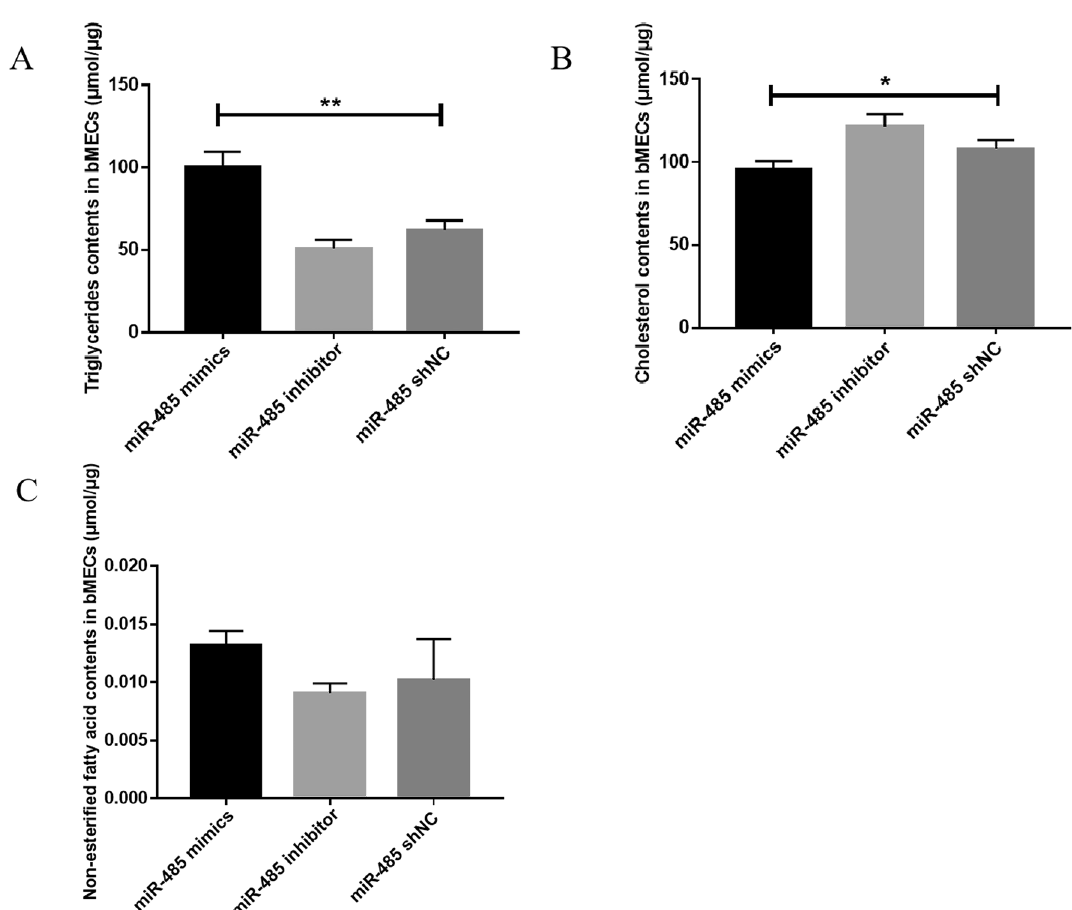
Figure 3. Detection of the TGs, CHOL, and NEFA contents of bMECs transfected with miR-485 mimics, miR- 485 inhibitor, or miR-485 shNC (** P < 0.01, * P < 0.05; ns means P > 0.05). ( A ) Triglyceride contents in